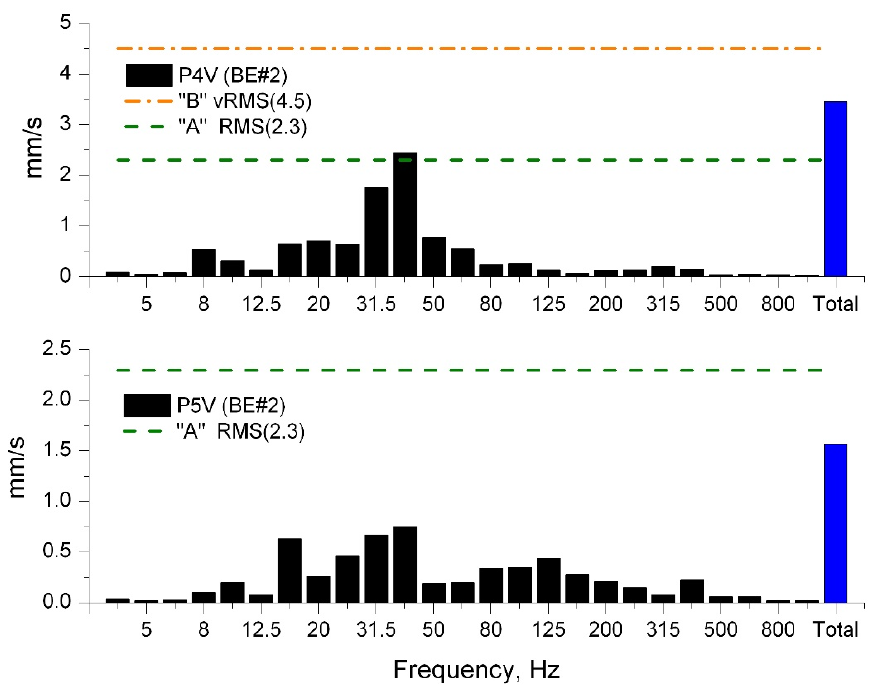
Figure 12. Typical spectrum of the RMS vibration velocity in the vertical direction at points P4 ( top ) and P5 ( bottom ) on the output shaft in bucket elevator BE#2. The column with the total value is marked in blue.